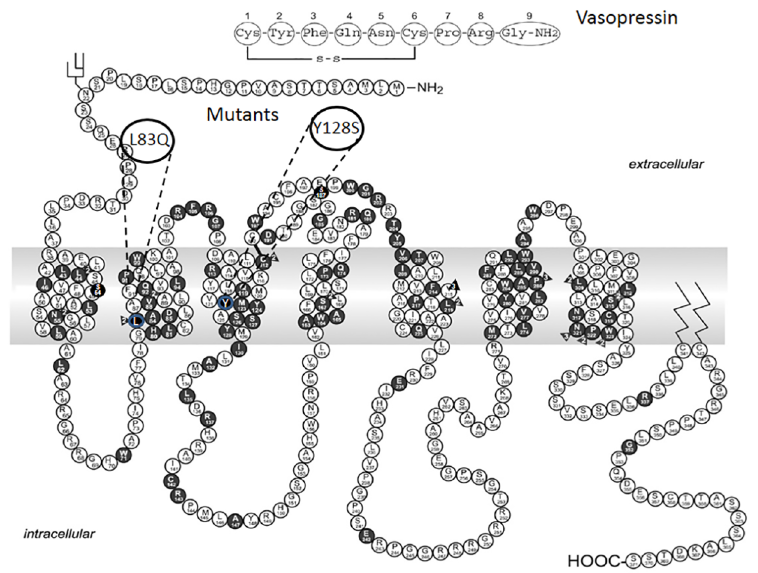
Fig 1. Map of the human arginine-vasopressin 2 receptor showing mutants associated with nephrogenic diabetes insipidus in black. The location of L83Q and Y128S, the mutants used in the present study, are shown. The amino acid sequenceof the naturally-occurringligand, vasopressin, is shown at the top. When there are multiplemutations at a singlesite, the numberof mutations is noted in a triangle. The mutants in this study are a blue circle so they stand out. Adapted and modified from